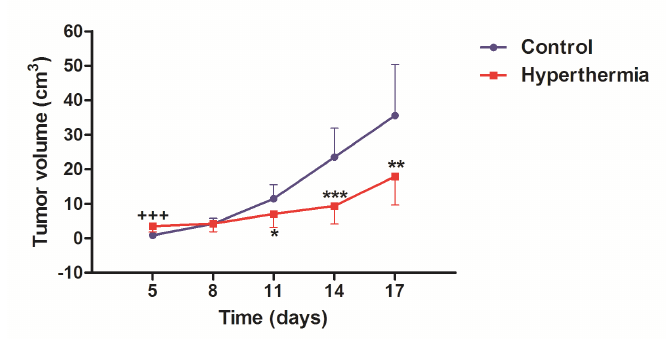
FIGURE 3 – Tumour growth during 17 days. Data expressed as Mean±Standard Deviation.